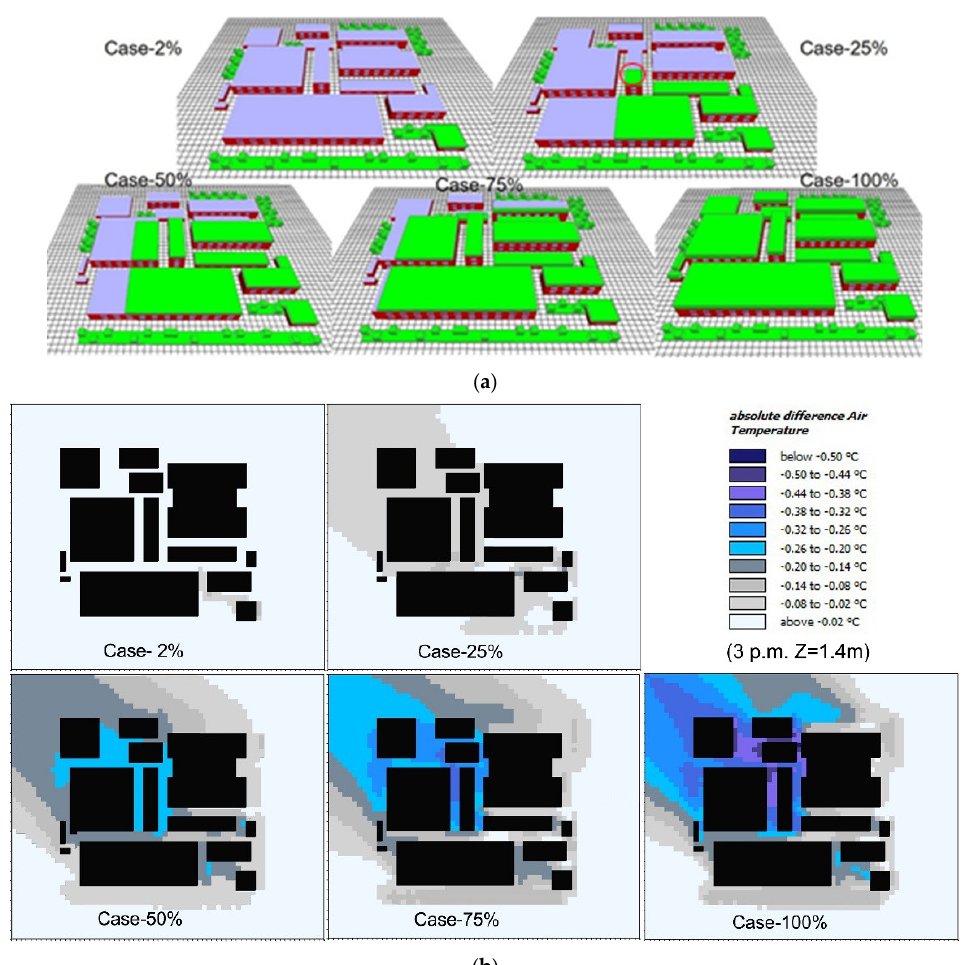
Figure 11. Comparison of the impact of greening coverage ratio on green roof cooling performance ( a ) Physical models, and ( b ) pedestrian air temperature reduction at 15:00 h.